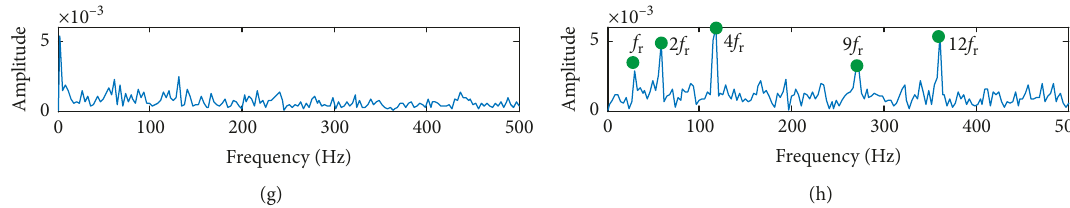
Figure 10: The frequency domain diagram of multiresolution DMD modes of the normal roller bearing signal, where (a)–(h) are cor- responding to signals in Figure 6, respectively. The characteristic frequencies of the normal bearing signal are distributed in multiple modes, and these multiple modes jointly represent the features of the normal signals.